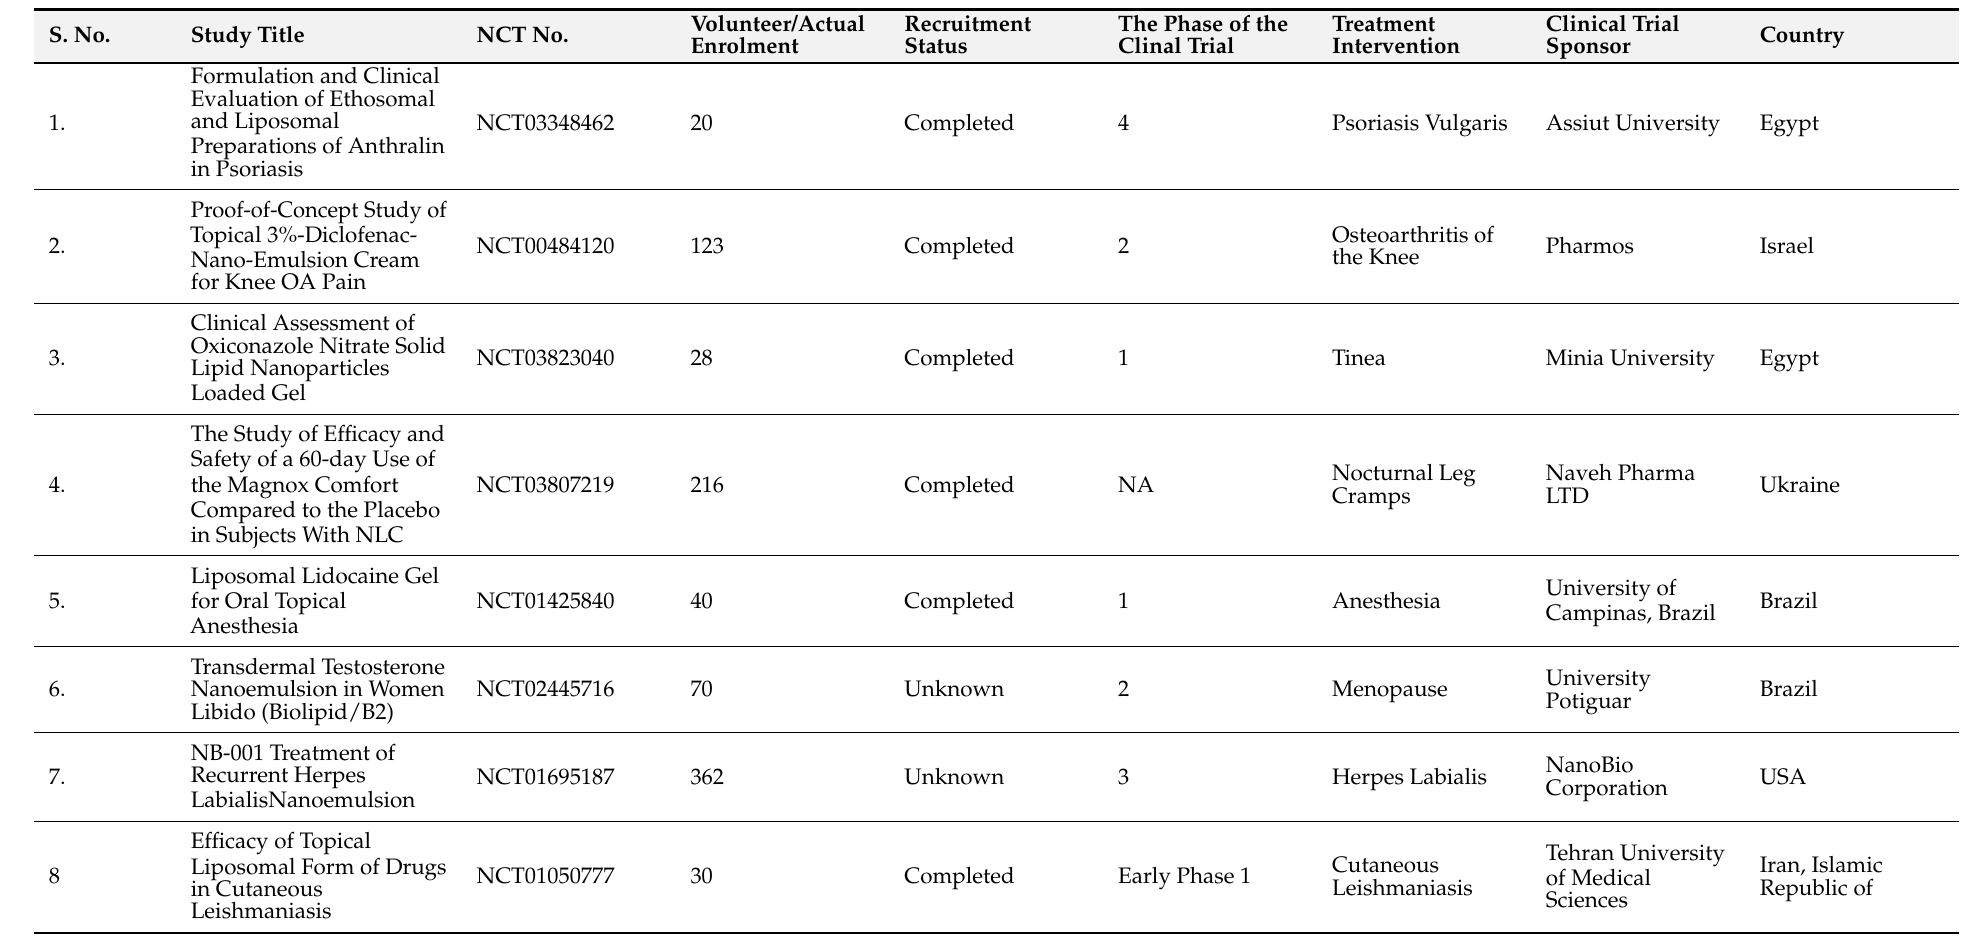
Table 2. Clinical trials relating to lipid carriers specifically crossing skin